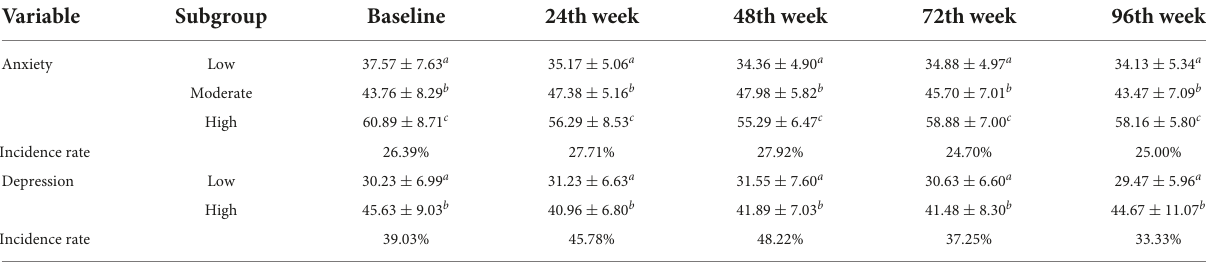
TABLE 4 Comparison of the subgroups of anxiety and depression at each follow-up point.